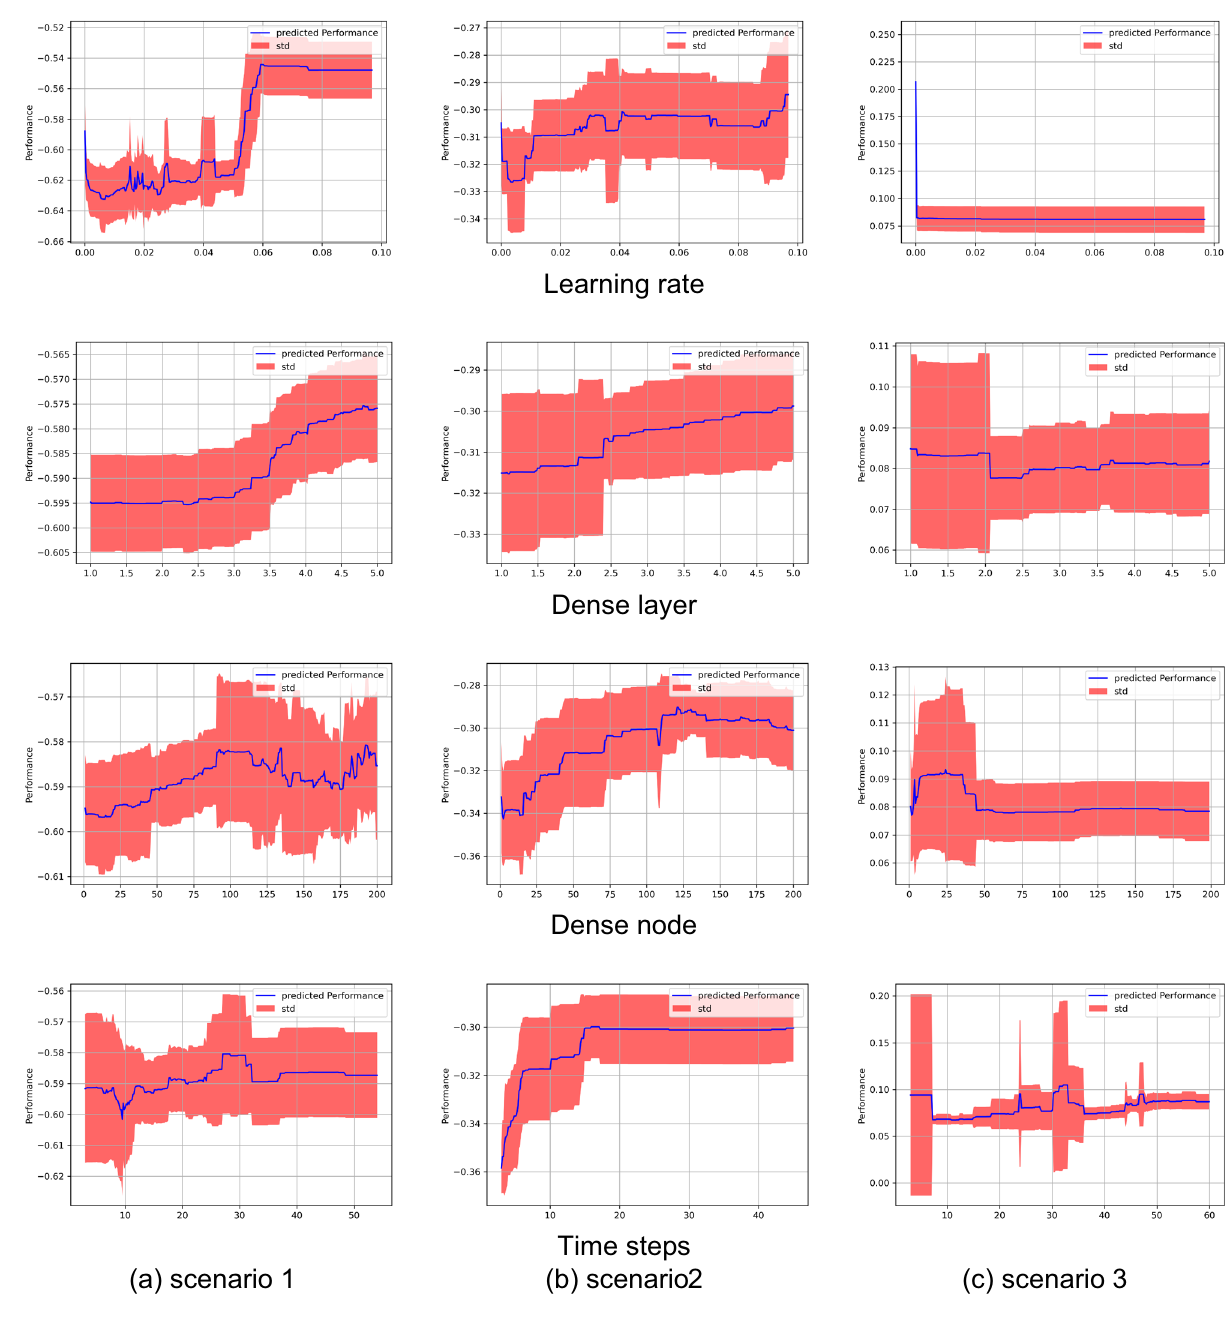
Fig. 10 The marginal plot of a ANN, b CNN, c CNN-GAF, and d LSTM performance with varied hyperparameter